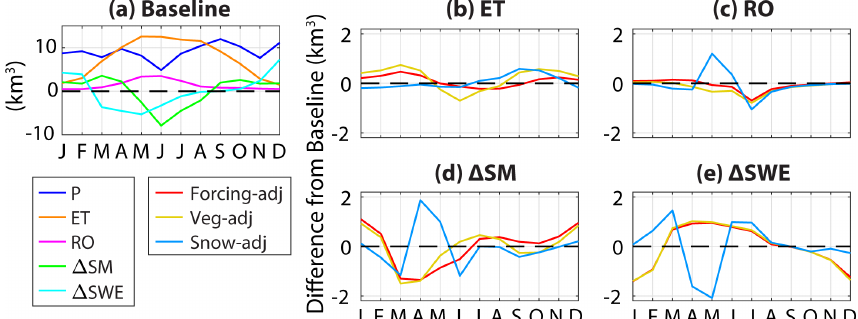
Figure 13. (a) Climatological monthly mean of the water balance components for the baseline simulations in the Upper Basin. P is pre- cipitation, ET is evapotranspiration and sublimation, RO is surface and underground runoff, and (cid:49) SM ( (cid:49) SWE) is the differences between soil moisture (snow water equivalent) at the end and beginning of the month. (b–e) Difference between each variable for the Forcing-adj, Veg-adj, and Snow-adj simulations and the baseline